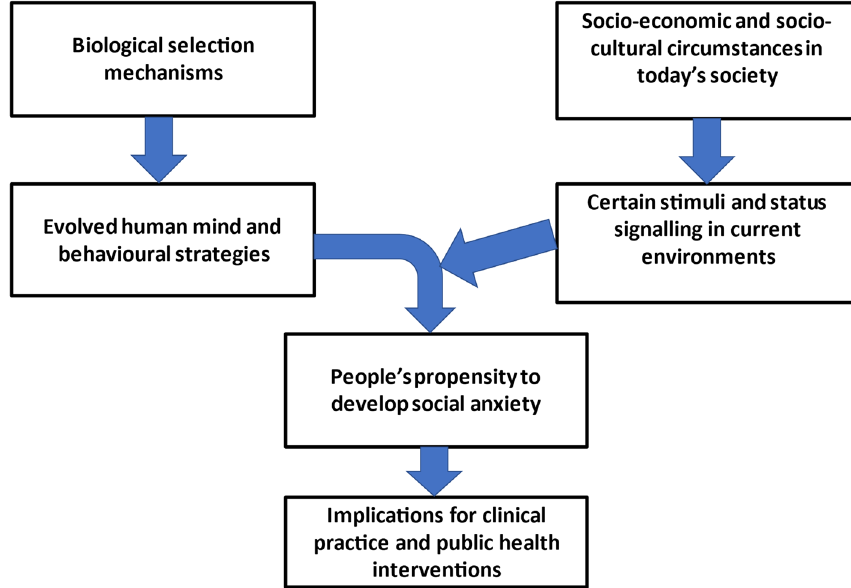
Fig. 1 A conceptual frame- work of social anxiety in modern societies from an evolutionary